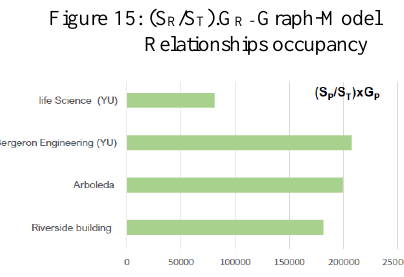
Figure 16: (S P /S T ).G P - Graph-Model properties occupancy